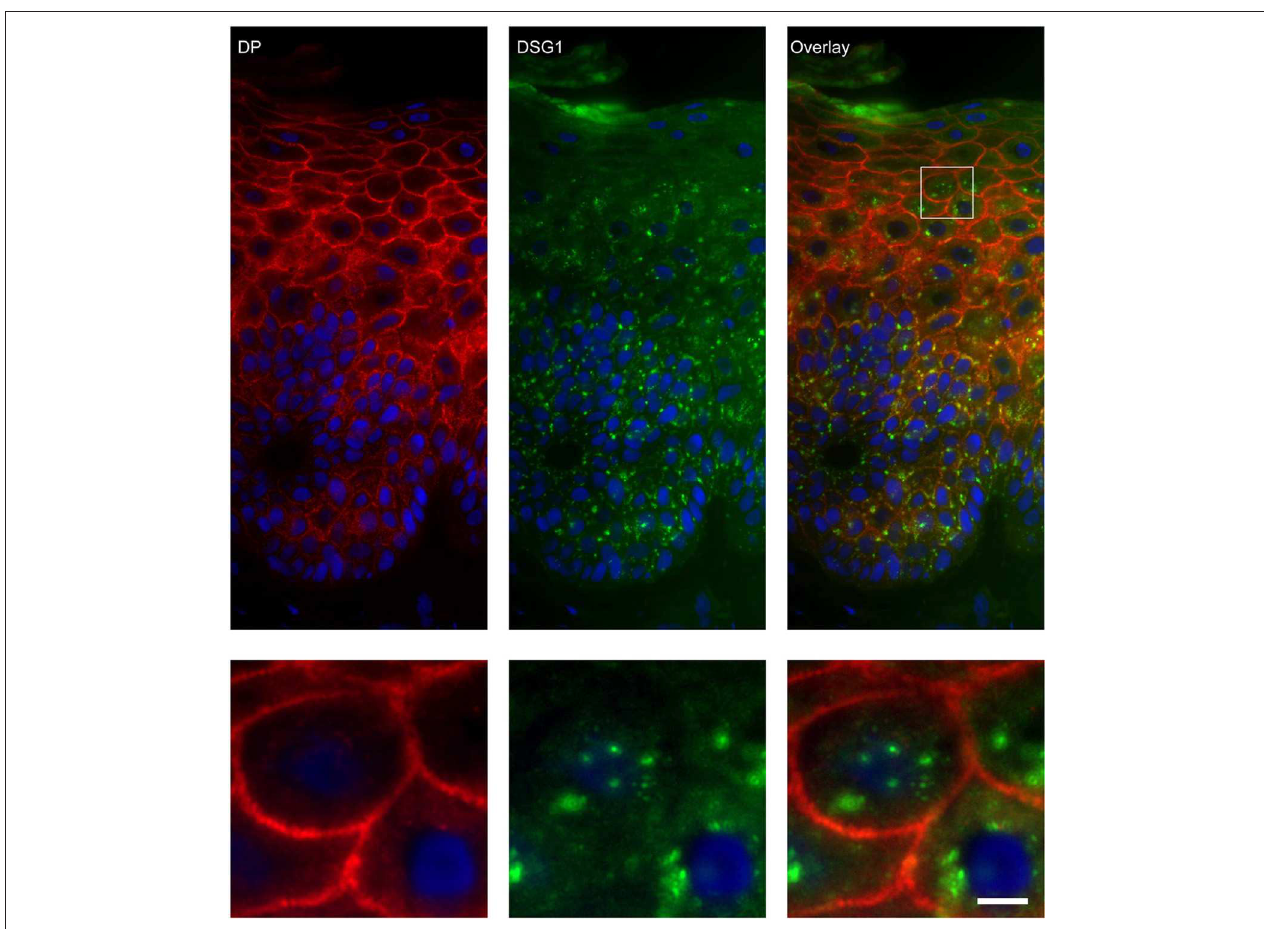
FIGURE 8 | Double staining of desmoglein 1 and desmoplakin shows no overlap in endosomes. The upper panel shows the overview, the lower panel shows the detail from the white box in the upper panel. White bar is 5 µ